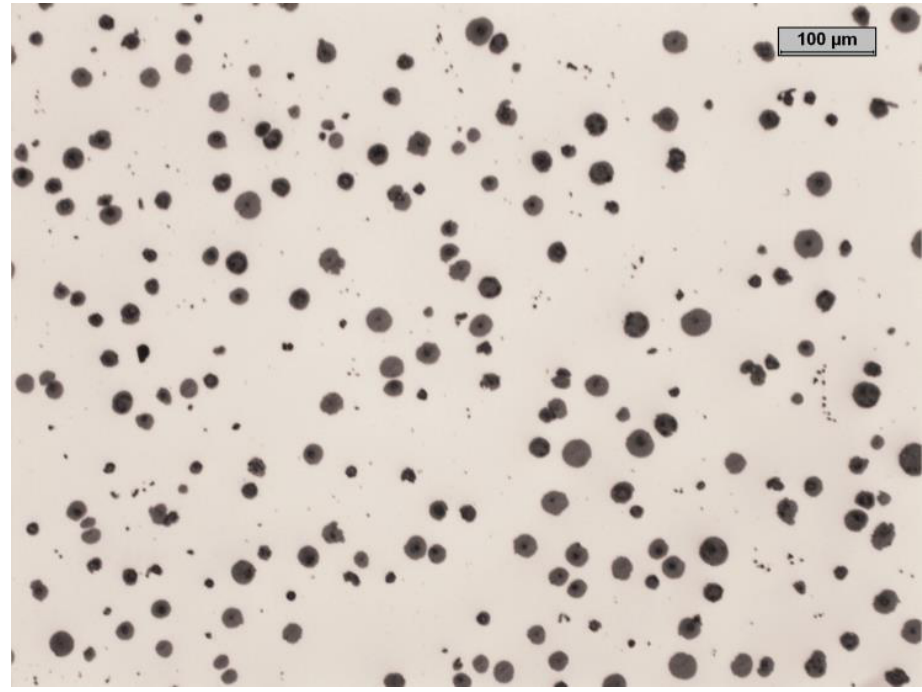
Figure 2. The non-etched microstructure of the investigated cast iron.